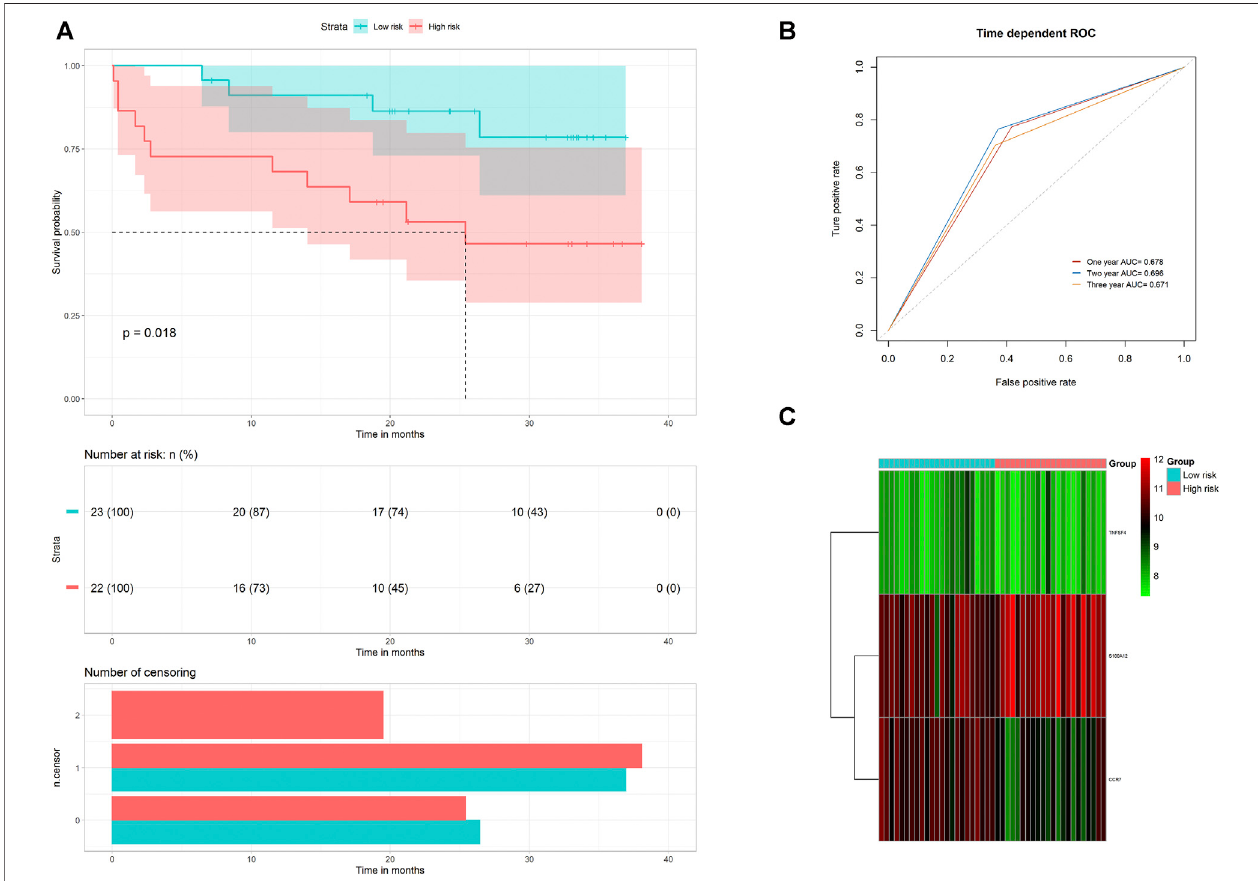
FIGURE 4 | Risk score analysis of the three-gene prognostic model in the GSE27957 cohort. (A) Survival curve for patients with low- or high-risk scores (B) ROC curves for forecasting overall survival based on the risk score. (C) heat map for gene expressions.